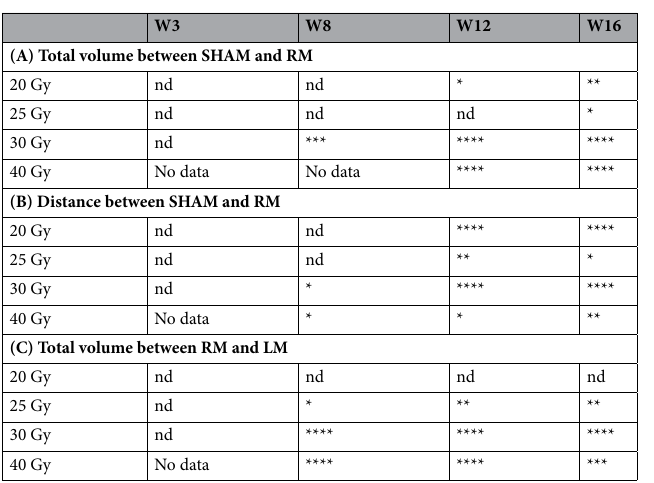
Table 1. Tables summarizing statistical differences in bone damage on the right (RM) and left mandibles (LM). Differences on right mandible between Sham and irradiated animals according to irradiation doses over time (A) for total bone volume and (B) for distance measurements. nd (no difference) or * versus sham. (C) Table summarizing statistical differences in total bone volume as analyzed between the left and right mandibles in irradiated animals at different doses and over time. nd (no difference) or * left versus right. Statistical analysis: Normality tests Shapiro /Kolmogorov then One-way ANOVA for all tests except for comparing the distance parameter on the right mandible between the Sham and 25 Gy irradiated rats, we used the Kruskall Wallis non-parametric test.